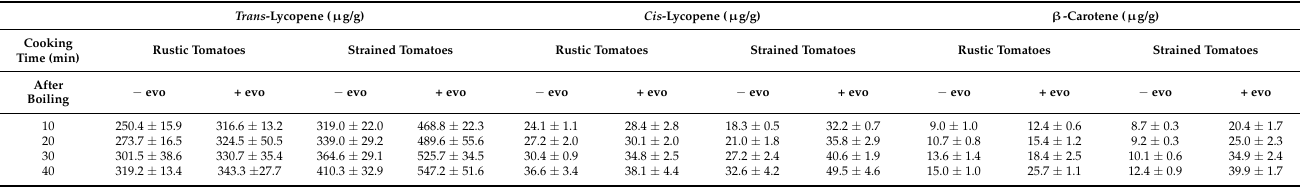
Table 2. Effect of cooking time and evo addition on trans and 5-cis-lycopene isoforms and β -carotene content in samples of sauces. Values represent the mean of three different measures ±